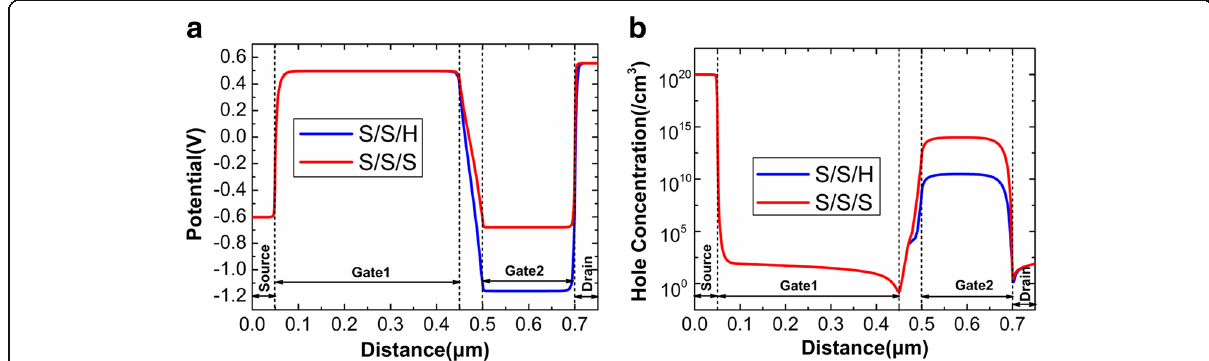
Fig. 8 a Potential contour after writing “ 1 ” . b Hole concentration after holding “ 0 ”